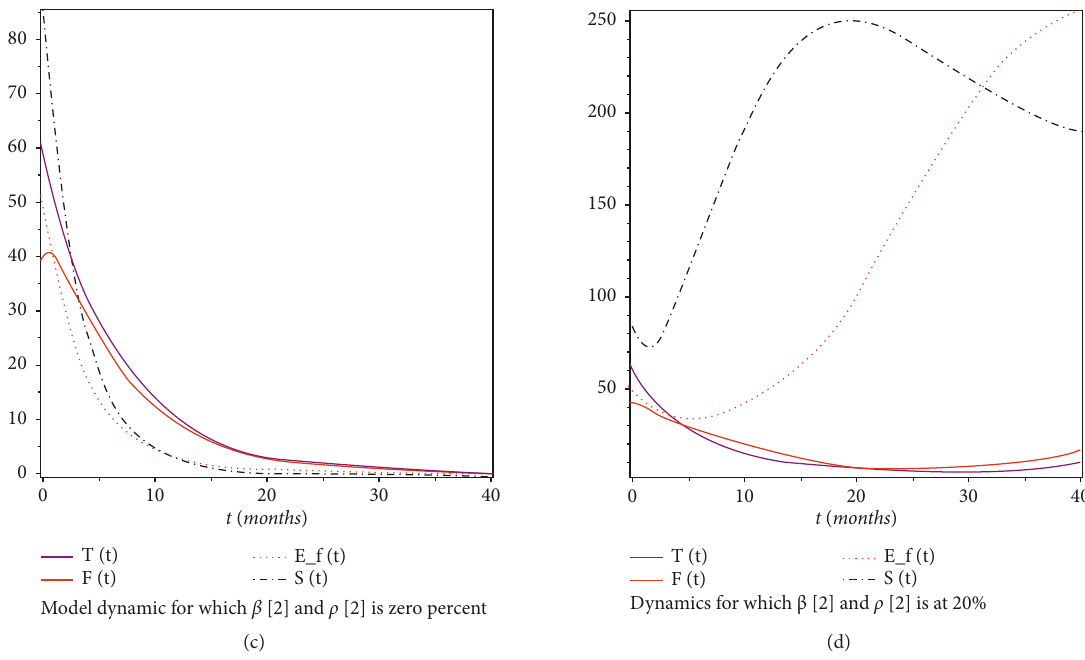
Figure 3: Model simulation. (a) The effect of increase in efforts of fanatical ( ( β � 0 , 0 . 2 , 0 . 4 , 0 . 6 , 0 . 8 , 1 . 0 ) ) for recruitment into ideology on 2 G(t). At start, many people seem to be embracing the ideology (i.e., the first 10-20 months of preaching the ideology, recruitment is growing), but beyond 20 months of preaching, recruitment becomes asymptotic for around 3000 people limit as seen in (a) (this proves assumption 4 of the propose model). (b) Success rate of fanatical recruiting into extreme fanatics. The simulation assumed ineffective implementation of government policy to curtail the menace will consequentially cause the fall in G(t) below threshold; 3000 population in (a). (c) The behaviour of the core groups in the absence of extremism, β [2] and ρ [2] are zero (i.e., effective implementation of government policy will eradicate extremism in the society, and the environment will be peaceful), while (d) dynamics of core populations at successful contact rate on the noncore group and successful embracement of ideology by fanatics (i.e., β [2] and ρ [2], respectively, are not zero, but at 20% minimum efforts). Table 2: Simulation for stability analysis (this is investigated by varying adequate contact rate of fanatics for recruitment). Λ β